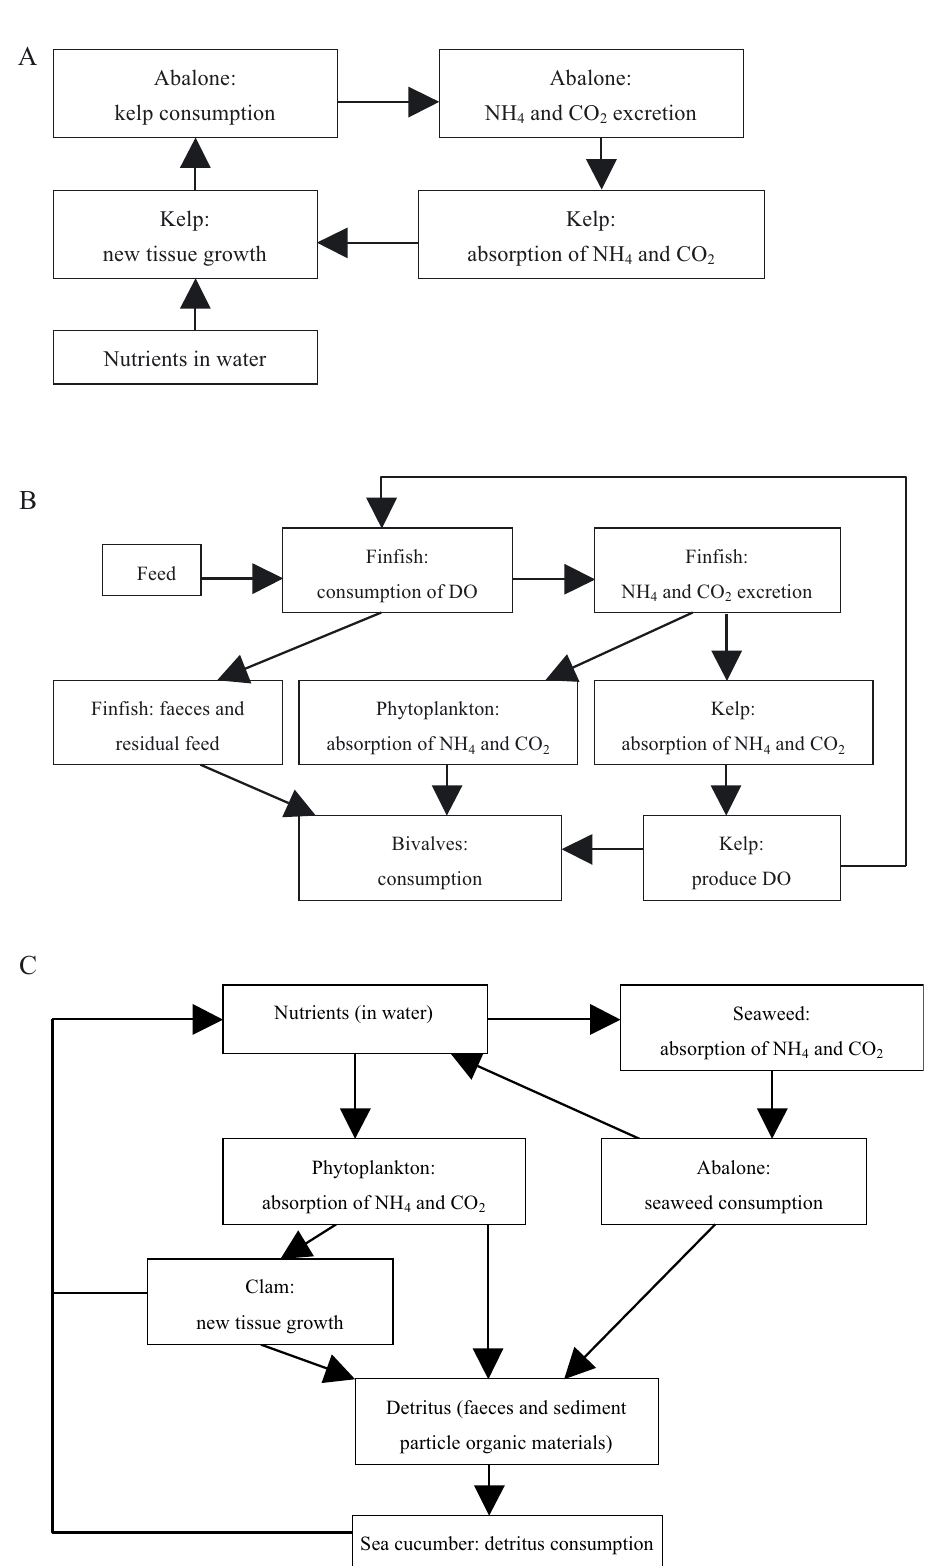
Fig. 2. Integrated multi-trophic aquaculture (IMTA) modes in Sanggou Bay, China, modified from Tang et al. (2013). (A) Long- line culture of abalone and kelp, (B) long-line culture of finfish, bivalve and kelp, and (C) benthic culture of abalone,